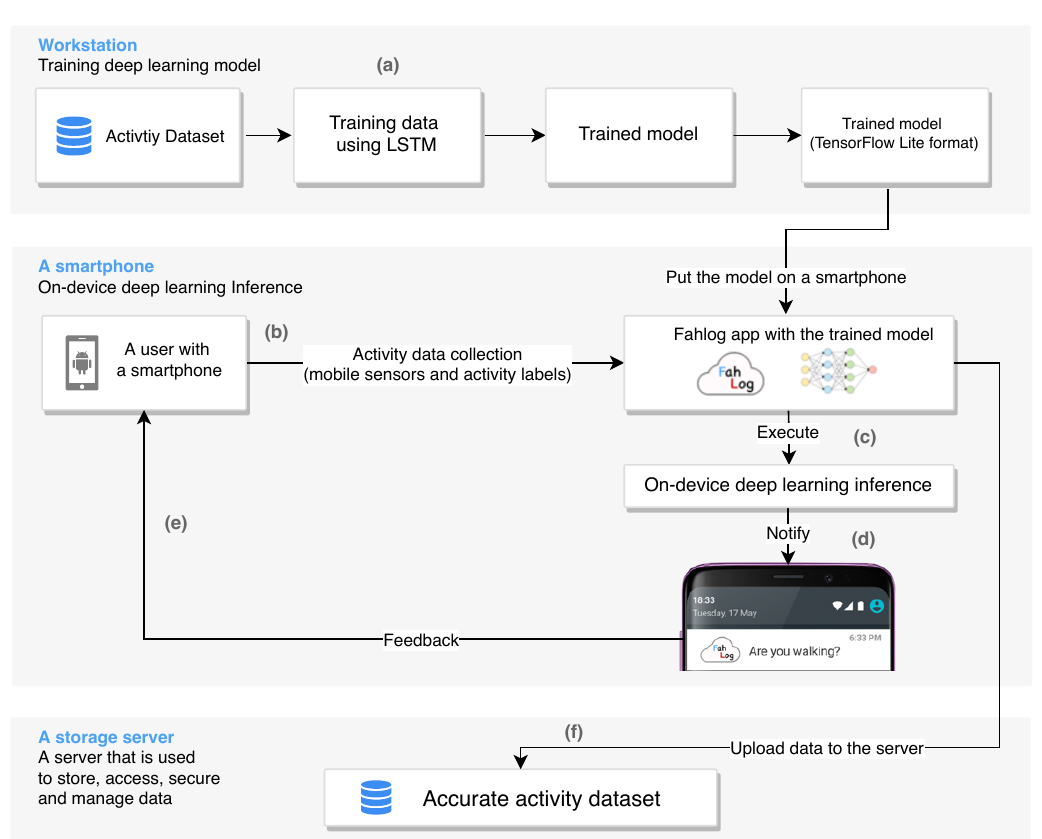
Figure 1. The system architecture of the proposed on-device deep learning inference for efficient activity data collection works as following ( a ) we first train activity labels with mobile sensors using an long short-term memory (LSTM) for recognition model and deploy it for on-device inference, ( b ) we collect mobile sensors and activity labels on a smartphone from a user, ( c ) the smartphone detects an activity that the user is doing by using an on-device deep learning inference model adopted, (d) the user receives information about the estimated activity as feedback (e.g., the notification is showing that “are you walking?” means the device is on a user who is walking), ( e ) the user repeats the process of activity data collection efficiently, and ( f ) we finally obtain accurate activity